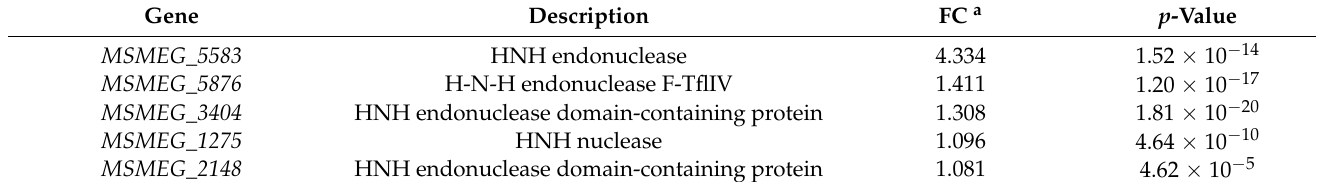
Table 2. Upregulated HNH family genes in response to MEMSG_6762 expression in M. smegmatis . Gene